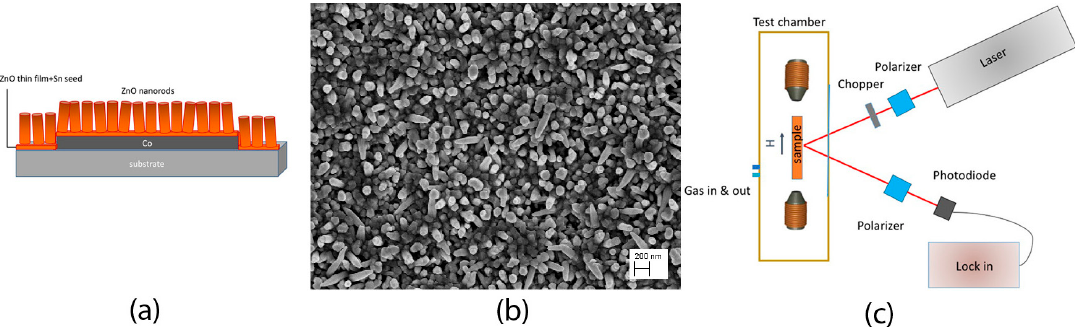
Figure 11. ( a ) Sketch of the sensing device; ( b ) SEM image of ZnO NRs surface; ( c ) Scheme of MOKE readout for gas sensing application.